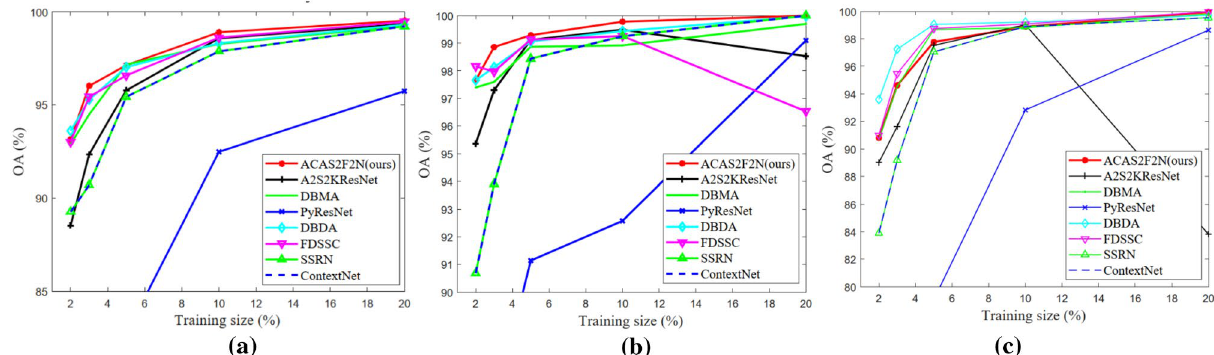
Figure 8. OA performance under different training sizes. ( a ) IP dataset. ( b ) KSC dataset. ( c ) Botswana dataset.